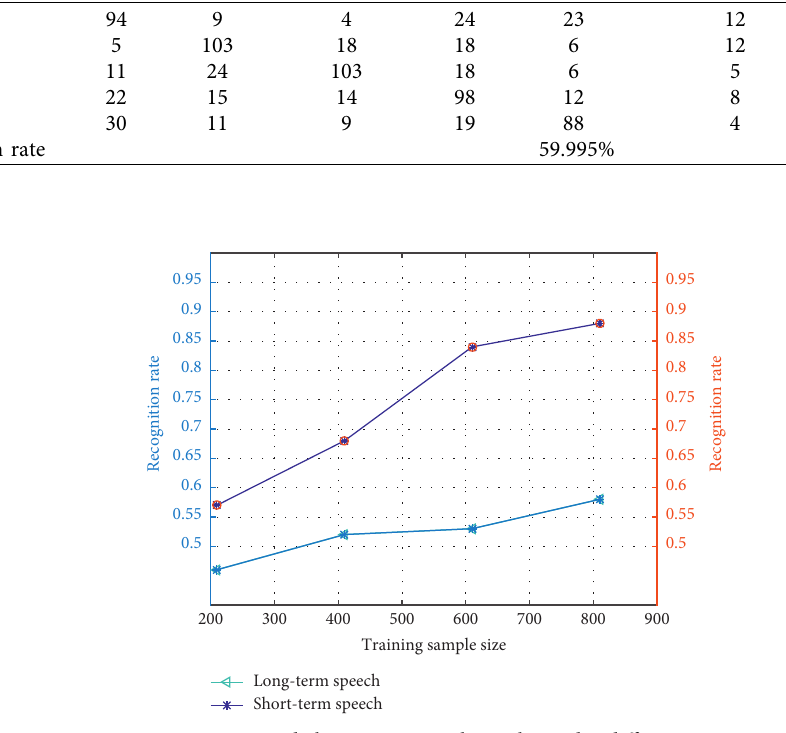
Figure 5: Long-term and short-term speech results under different training sets.